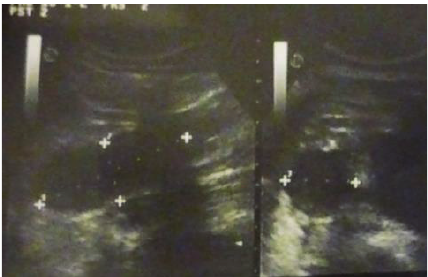
Figure 1: Sonographic images revealed a well-defined mass with lobulationandhypoechoiccontentintheposteroinferioroftheright